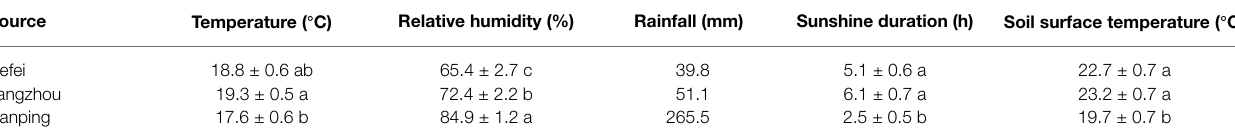
TABLE 3 | ANOVA of the climatical factors among the three nurseries.